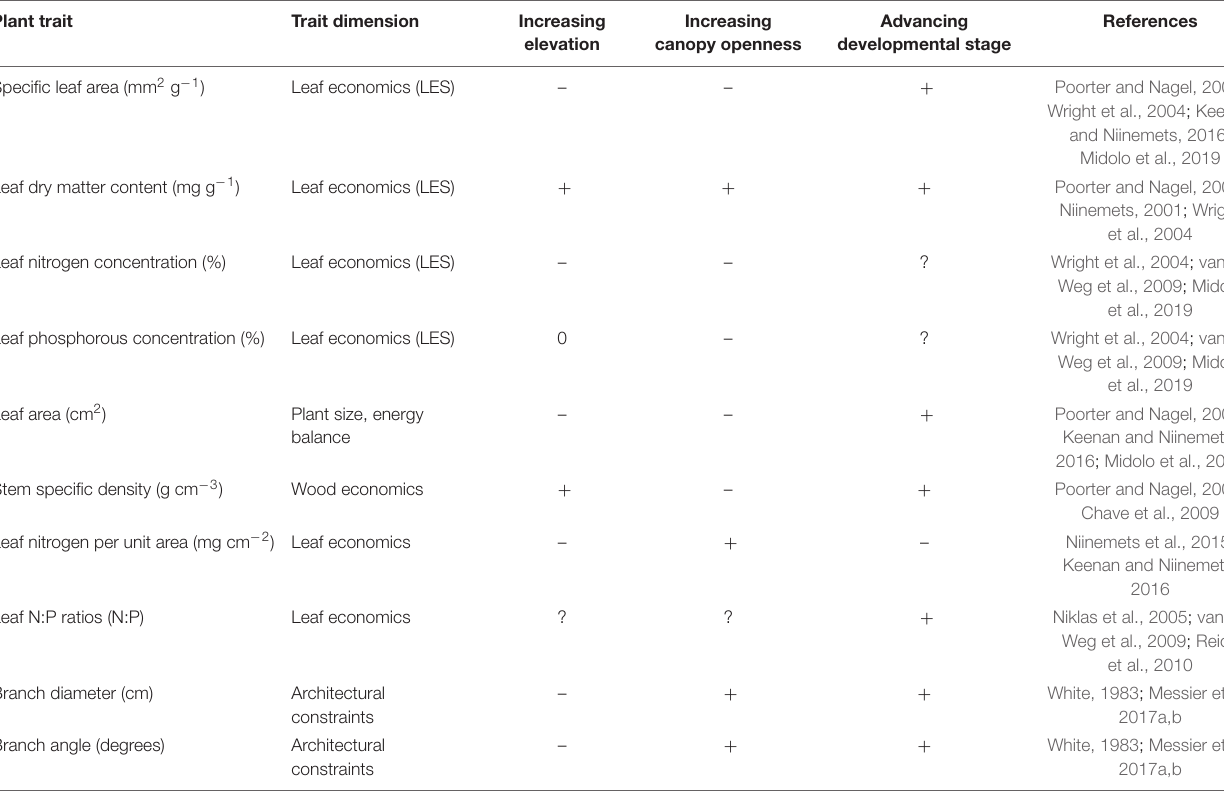
TABLE 1 | Hypothesized trait value responses of specific plant traits to gradients in elevation, canopy openness, and developmental stage 1 . Plant trait Trait dimension Increasing